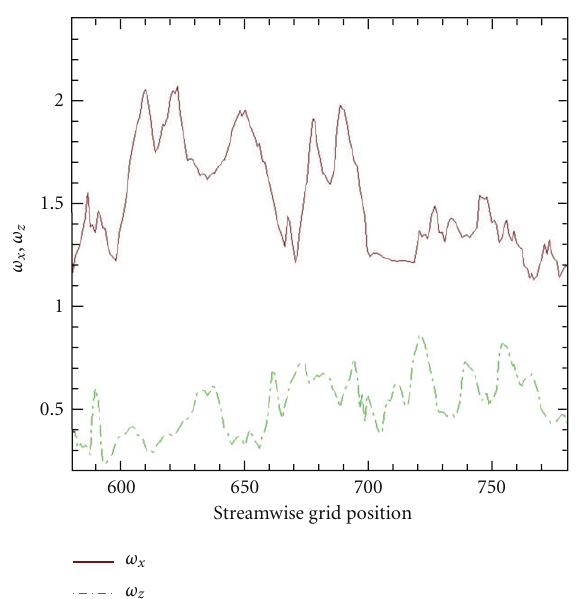
Figure 18: Maximum streamwise and spanwise vorticity along x - coordinate (Helmoholtz vorticity conservation).